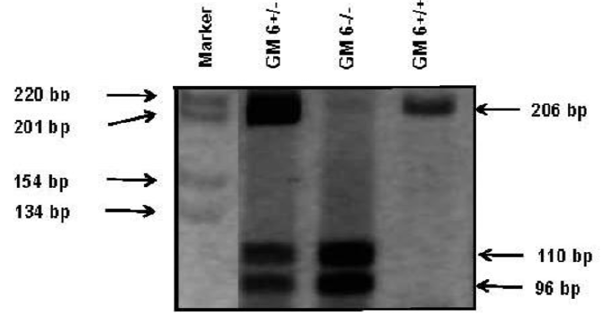
Figure 1. Restriction fragment length polymorphism analysis for GM6